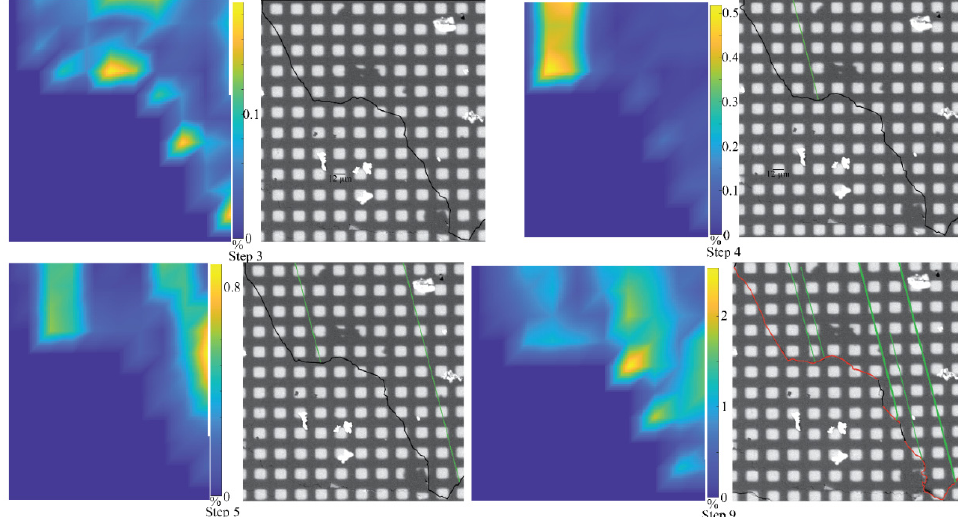
Figure 14. Equivalent Von Mises deformation map of crystal 7 at different steps of sample deformation. The black lines represent the grain boundaries. The green lines show the twinned planes. The red lines show the fracture zones.